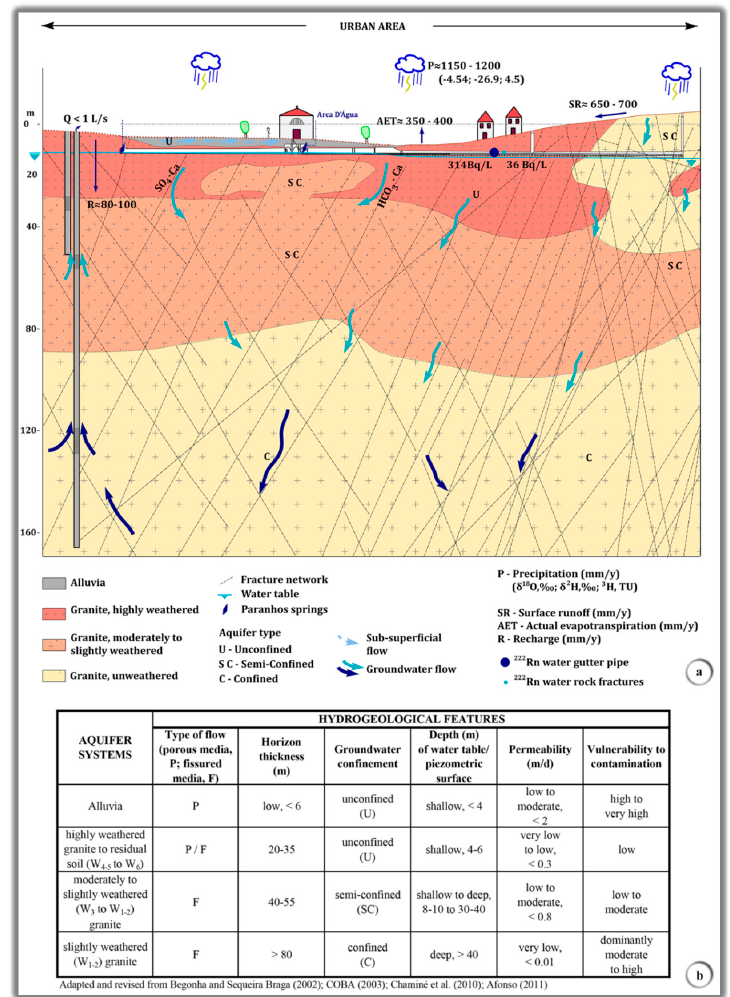
Figure 10. Urban hydrogeological conceptual model ( a ) and hydrogeological features of the main aquifer systems ( b ) as resulted from the integrated approach (revised and updated from [28]).